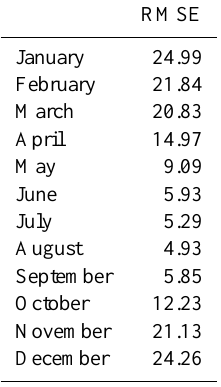
Table 1. Root mean square error (RMSE) of the calculated to the measured percentages of solid precipitation for each month over the period